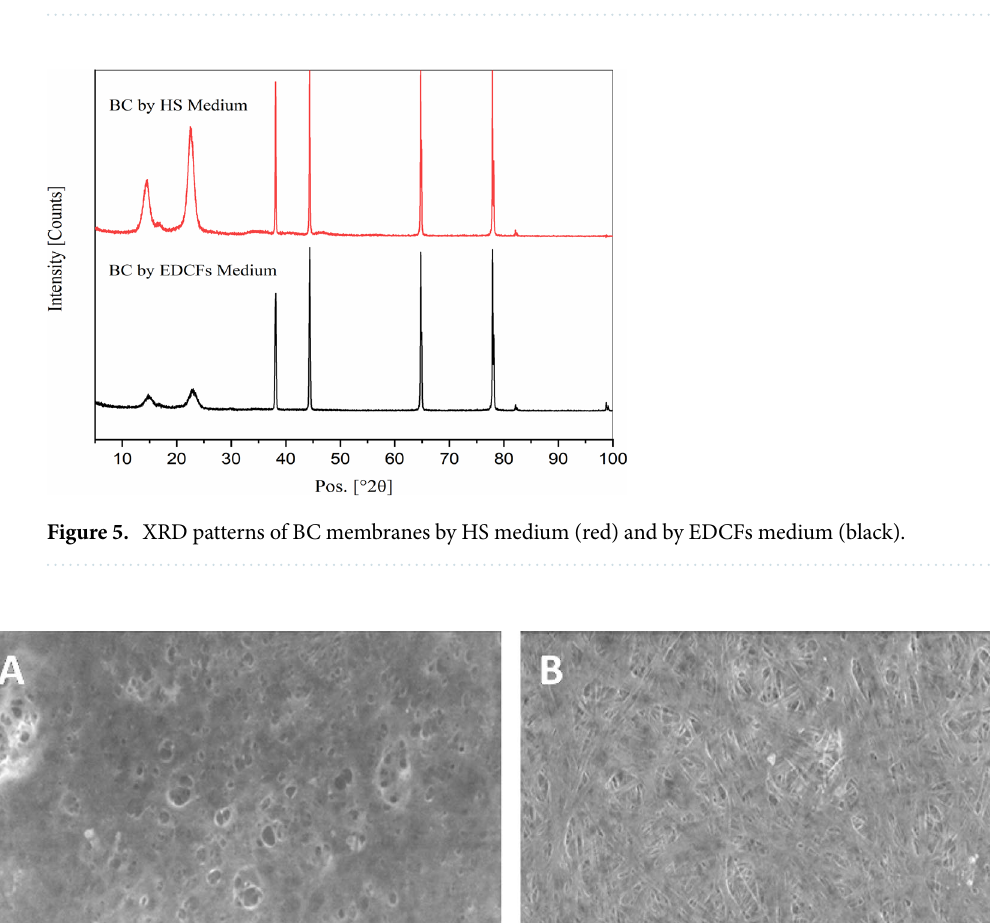
Figure 4. FTIR spectra of BC by HS medium (red) and that based on EDCFs medium (black) lines.